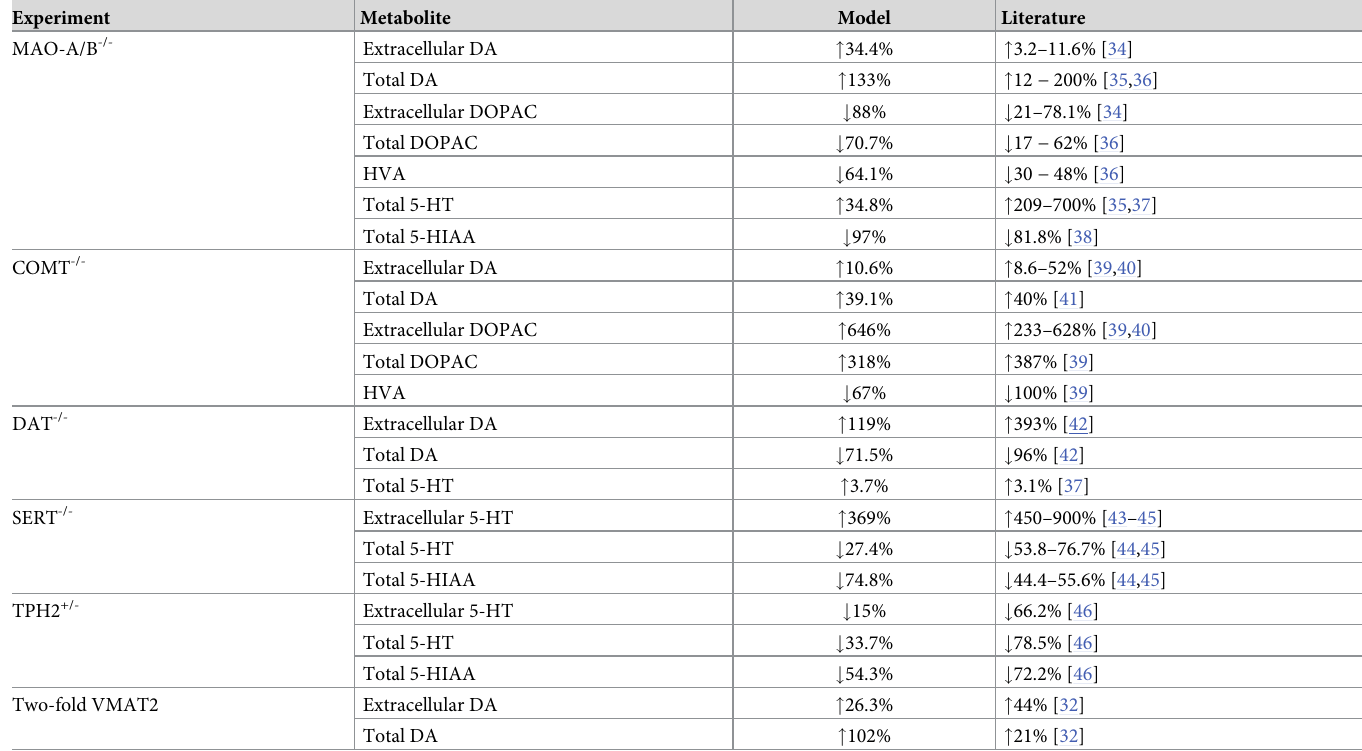
Table 1. Metabolite changes predicted by the model in comparison to corresponding values found in the literature. Abbreviations: 5-HT, serotonin; COMT, catechol O-methyltransferase; DA, dopamine; DAT, dopamine transporter; DOPAC, 3,4-dihydroxyphenylacetic acid; HVA, homovanillic acid; MAO, monoamine oxidase; SERT, Model